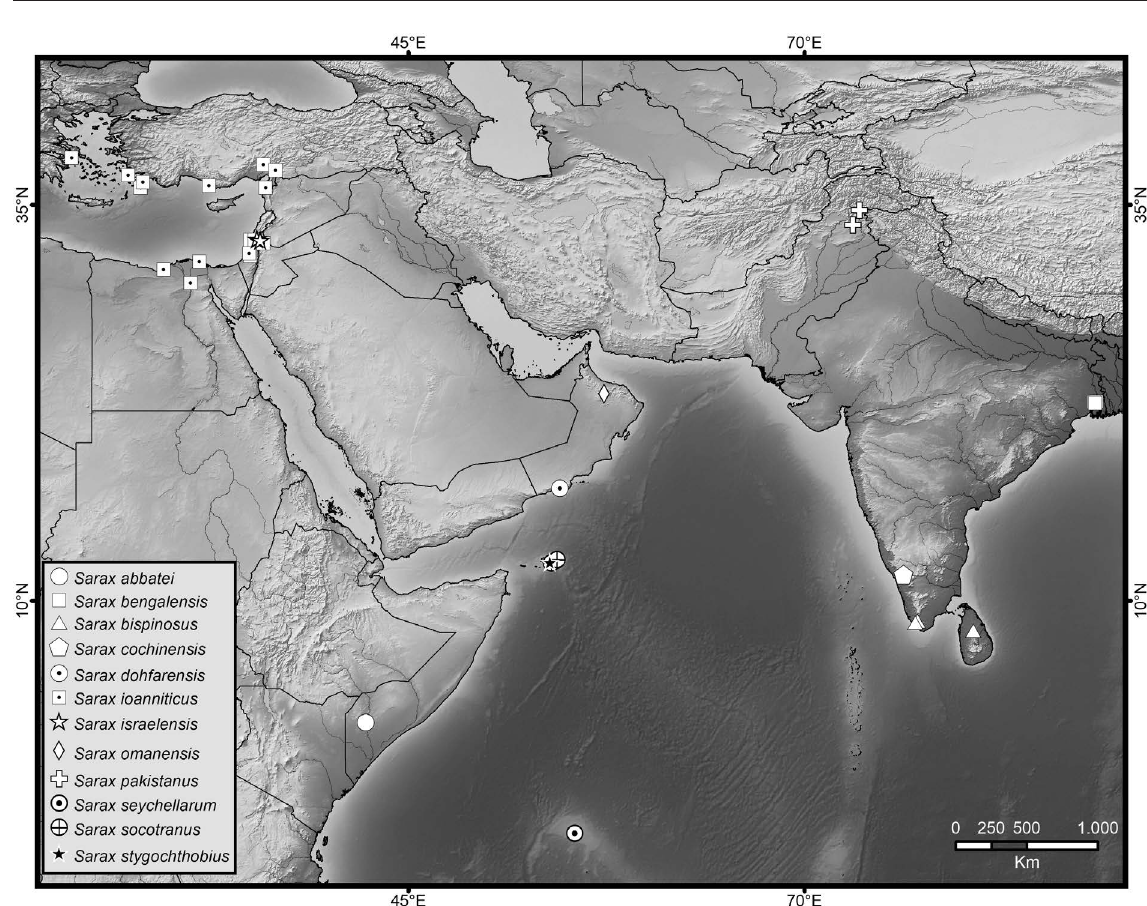
Fig. 135. Map plotting known distributions of species of Sarax Simon, 1892 in Africa, the Middle East and South